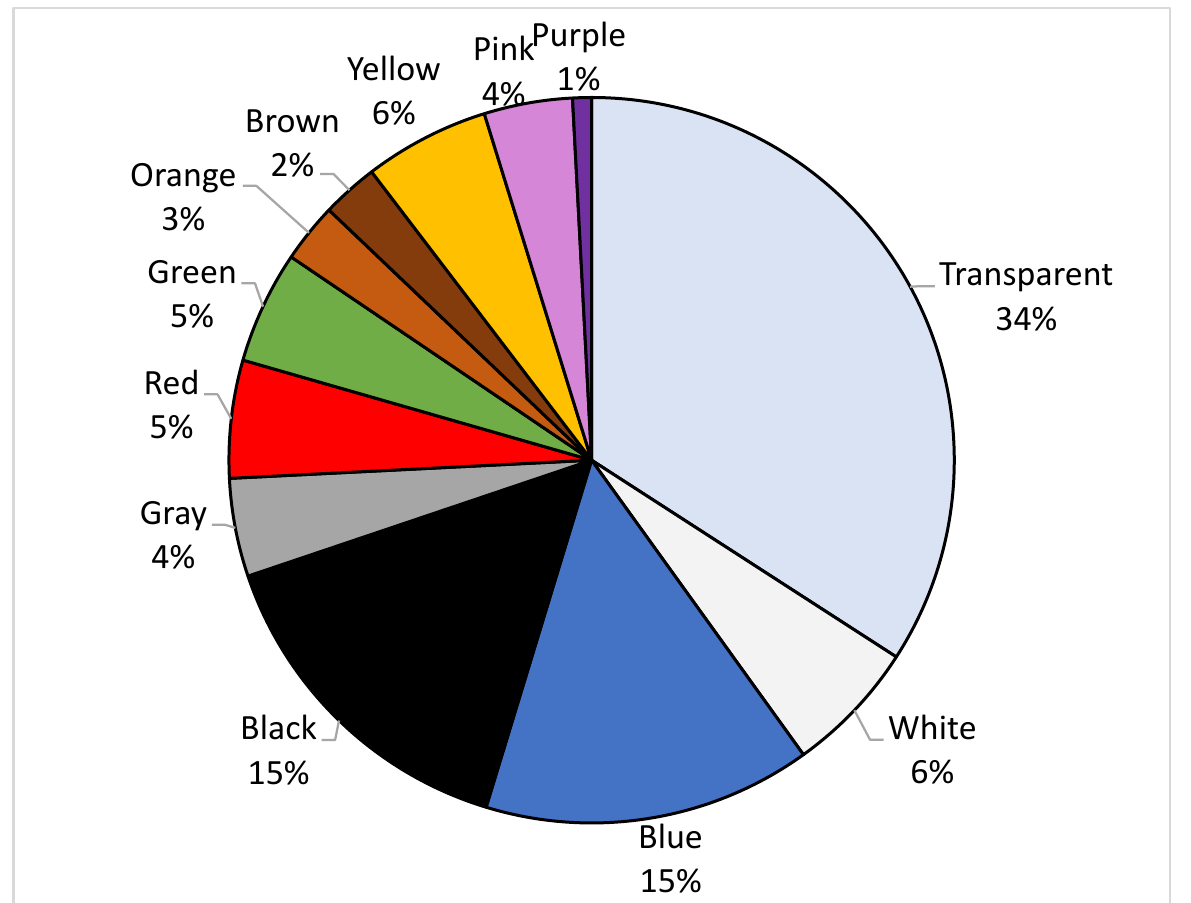
Figure 3. Microplastic color abundance in the water of the three studied rivers.